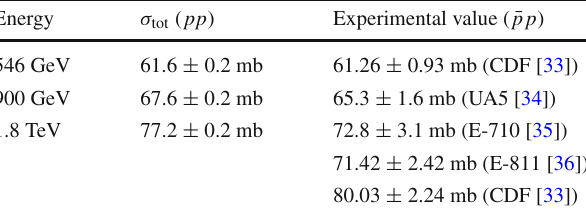
Table 4 Predictions of the PB model for the total cross section con- sidering pp collisions at different values of the center-of-mass energy. For comparison, the experimental results for ¯ pp scattering are also pre- sented Energy σ tot ( pp